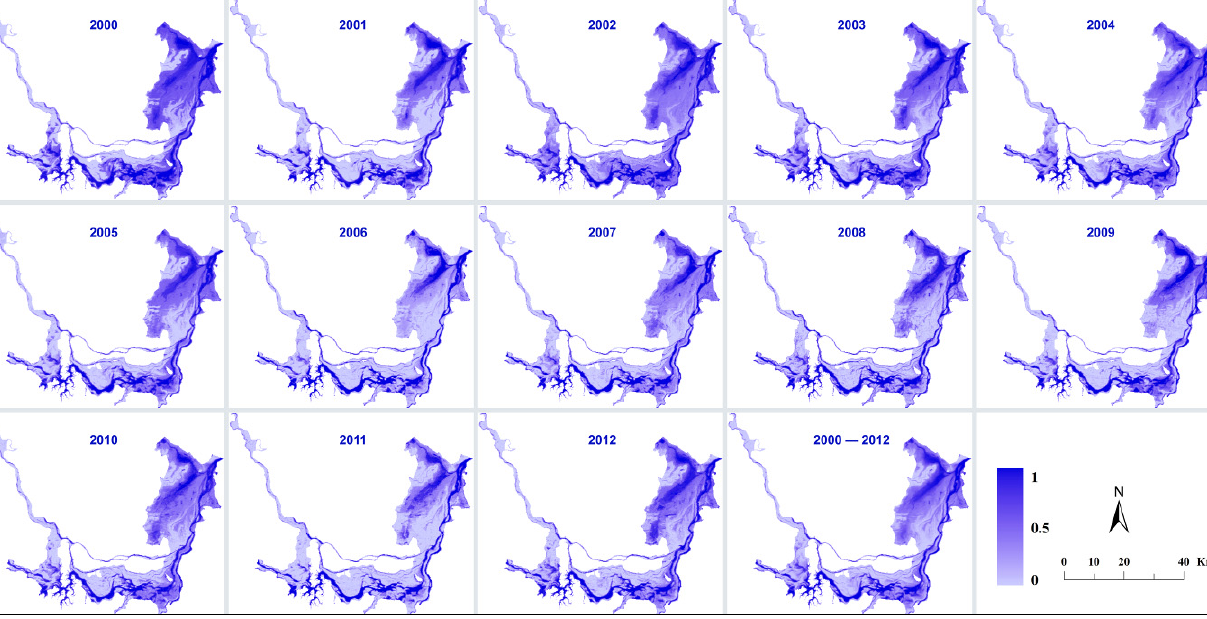
Figure 7. Spatial and temporal variations in flood inundation probability during 2000 to 2012 in the Dongting Lake.